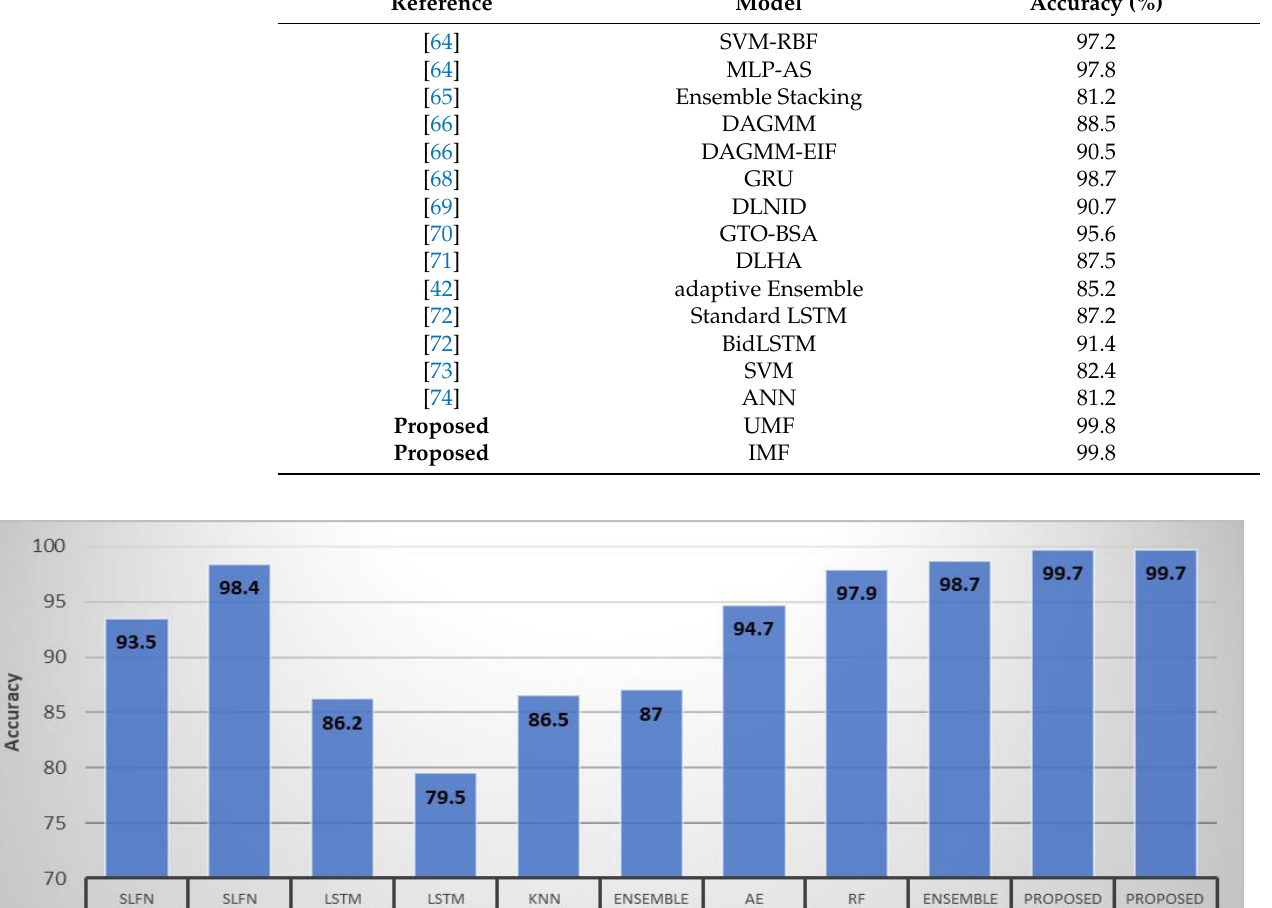
Figure 12. The comparison of accuracy result of our detection model performance and related works of NSL-KDD. Table 14. The comparison of accuracy result of our detection model performance and related works of NSL-KDD.